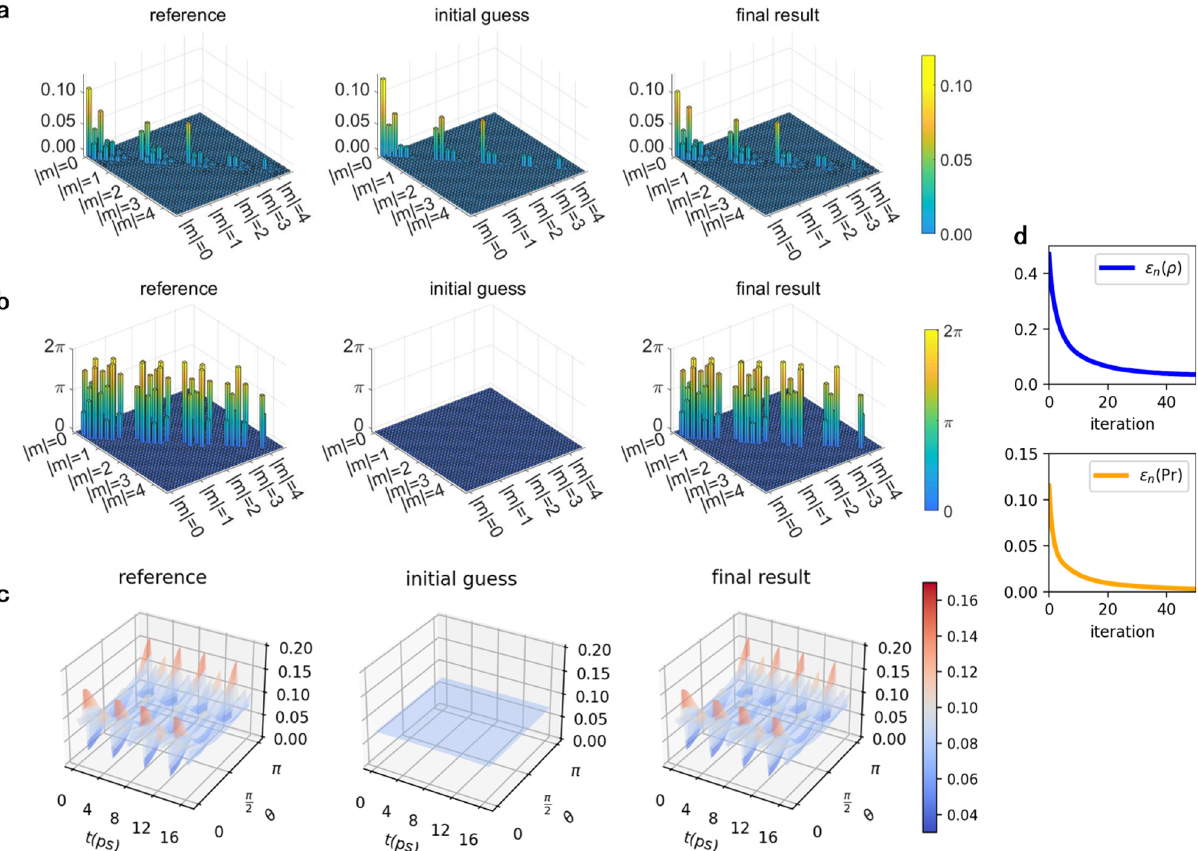
Fig. 3 Quantum tomography of rotational wavepacket of nitrogen molecule. The a moduli and b phases of density matrix elements. Within each m -block J ¼ j m j ; j m j þ 1 ; (cid:4)(cid:4)(cid:4) ; J t = 0). The density matrix elements of opposite magnetic quantum numbers m and − m are identical (see max (phases are at Supplementary Eq. 21). Density matrix elements of higher m -blocks are not plotted due to their small moduli. c The wavepacket probability distribution Pr( θ , t ), which is cylindrically symmetric in azimuthal direction of ϕ . The convergence of the procedure is illustrated in d , where the error of density matrix ϵ ð ^ ρ Þ and the error of probability density ϵ (Pr) are de fi ned in Supplementary Eq. 33 and 34.